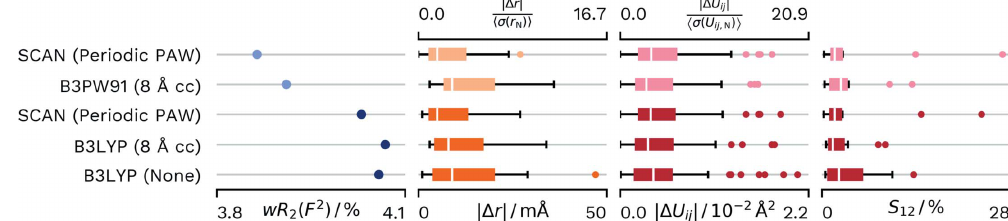
Figure 5 Differences in wR 2 ( F 2 ) and agreement with neutron values for different density sources for HAR of HMa-8HQ . Distributions of parameters are displayed as box-whisker plots. SCAN (Periodic PAW) was conducted with our script and GPAW . The B3PW91 (8 A˚ cc) values are from the reference calculation from the literature (Malaspina et al. , 2021 b ) and used 8 A˚ of cluster charges for the crystal approximation. B3LYP (8 A˚ cc) uses 8 A˚ of cluster charges and was refined with NoSpherA2 / TONTO . B3LYP (None) was calculated with NoSpherA2 / ORCA without any approximation of the crystal environment. Lighter coloured datasets have an F / (cid:2) ( F ) cut-off of 4 as applied in the reference.